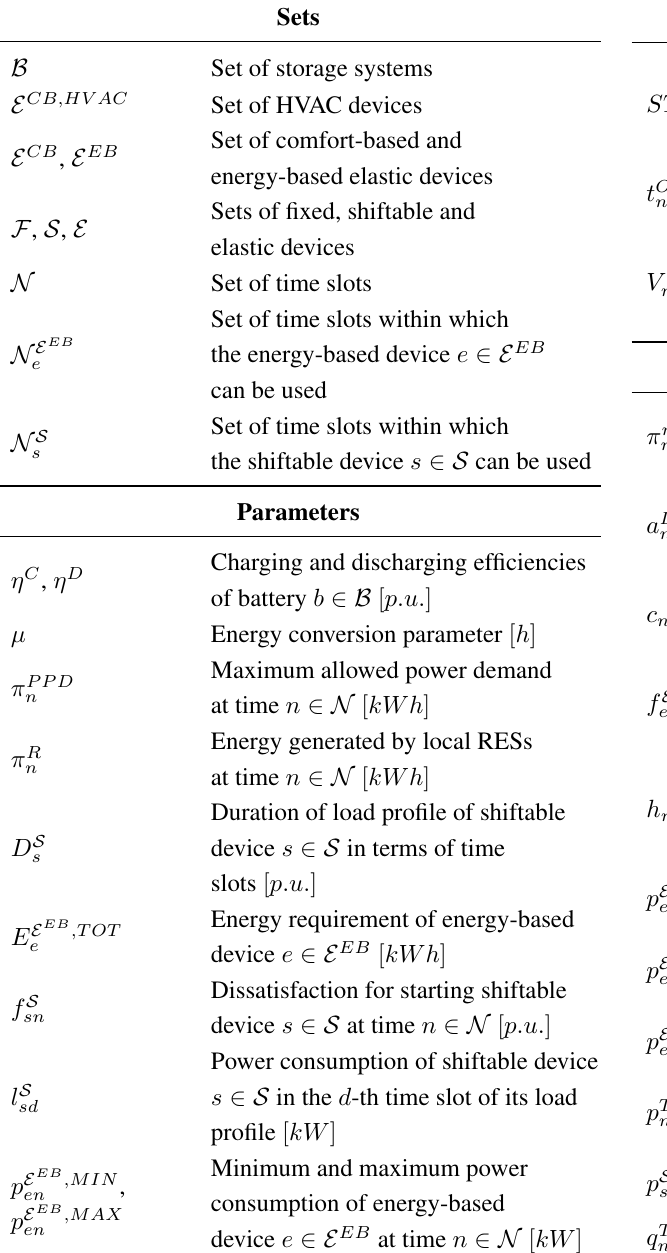
Table 2. The main notations of the DSM optimization